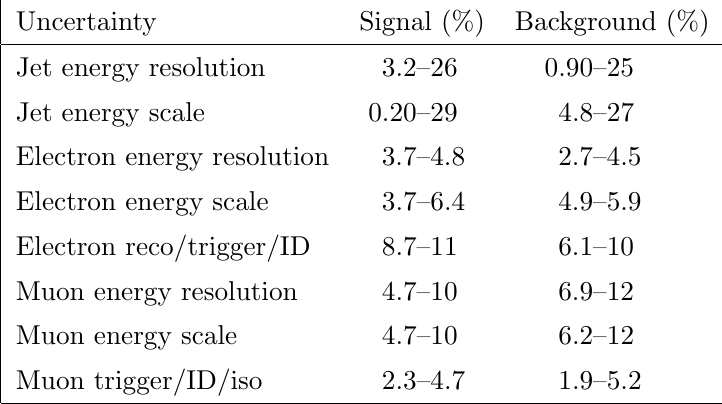
Table 2 . E(cid:11)ect of systematic uncertainties in candidate reconstruction e(cid:14)ciencies, energy scale and resolutions on the signal and background yields. The Signal column shows the range of uncertainties computed at each of the W R mass points. The Background column indicates the range of the uncertainties for the backgrounds.